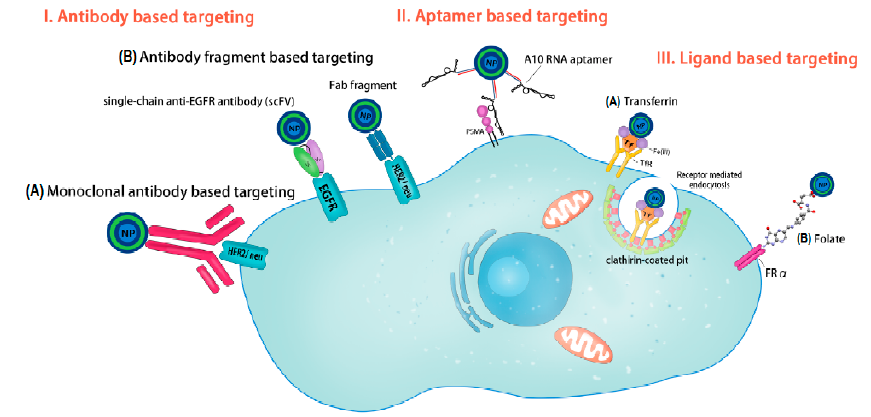
Figure 1. A schematic depicting method employed for active targeting of nanoparticles. I. Antibody-based targeting, which involves the use of: (A) monoclonal antibodies such as anti-Her2/neu antibody directed toward Her2/neu receptors on the target cell membrane; and (B) antibody fragments: single-chain variable fragments (scFV) such as single-chain anti-epidermal growth factor receptor (EGFR) antibody directed toward EGFR, or antigen-binding fragment (Fab) such as anti-Her2/neu Fab. II. Aptamer-based targeting such as the A10 RNA aptamer directed toward prostate-specific membrane antigen (PSMA) on the surface of the target cells. III. Ligand-based targeting such as: (A) transferrin-based targeting of nanoparticles toward transferrin receptors where uptake of the nanoparticles takes place through receptor-mediated endocytosis through clathrin-coated pits; and (B) folate-based targeting using folic acid (FA) to target folate receptor alpha (FR α ), which is upregulated on the surface of neoplastic cells. (Reprinted from [23] with permission from Cancer Research Clinical